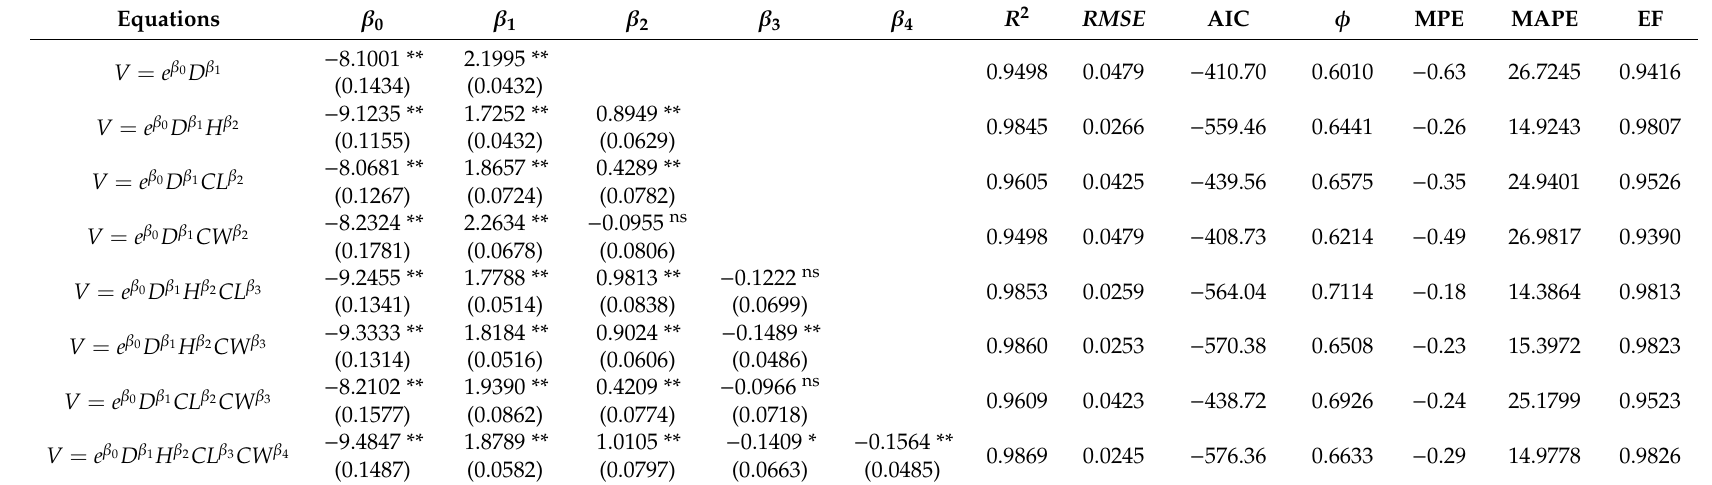
Table 4. Parameter estimates, standard errors (in parenthesis), goodness-of-fit statistics, jackknifing validations, and the parameter of weight functions ( φ ) for eight stem volume equations based on di ff erent predictor variables for Populus × xiaohei